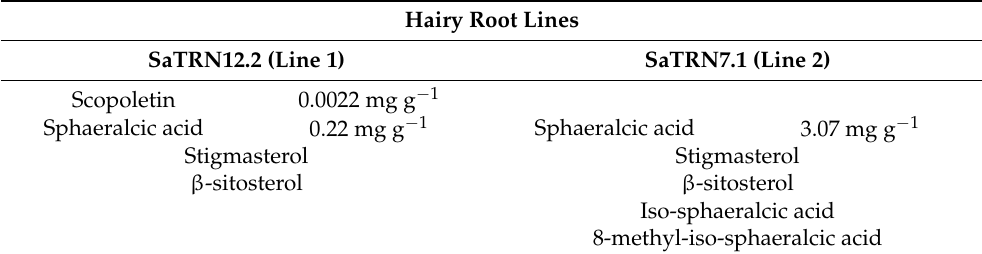
Table 1. Compounds identified and isolated from the dichloromethane–methanol extracts of the SaTRN12.2 (line 1) and SaTRN7.1 (line 2) hairy root lines of Sphaeralcea angustifolia